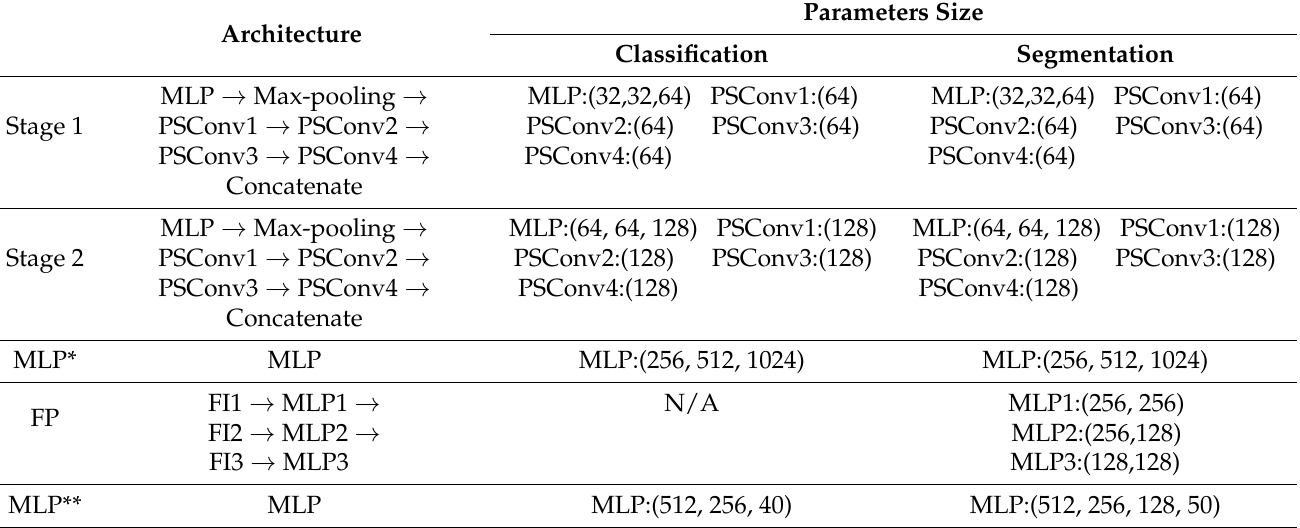
Table A1. Network details of PSNet. Numbers in each bracket represent the numbers of hidden units in successive hidden layers. For the PSConv layer, we list the output channel dimensions. FP denotes Feature Propagation and FI denotes Feature Interpolation, which are operations for point segmentation. MLP* denotes MLP operation after Stage 2, and MLP** is the last MLP for label